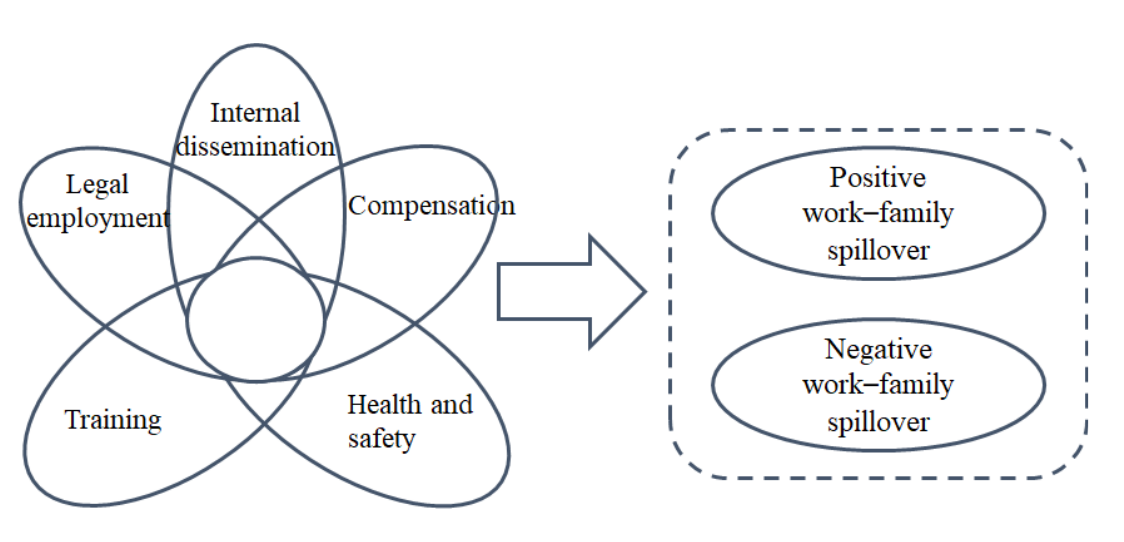
Figure 1. Configuration framework.